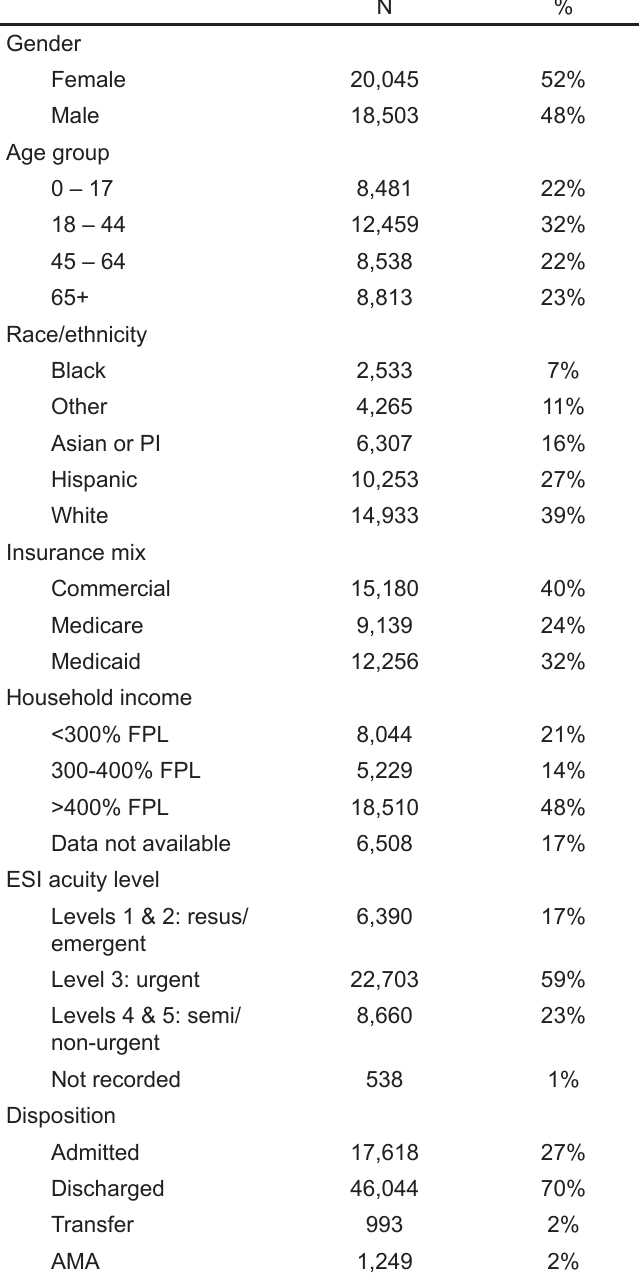
Table 1. 2019 baseline